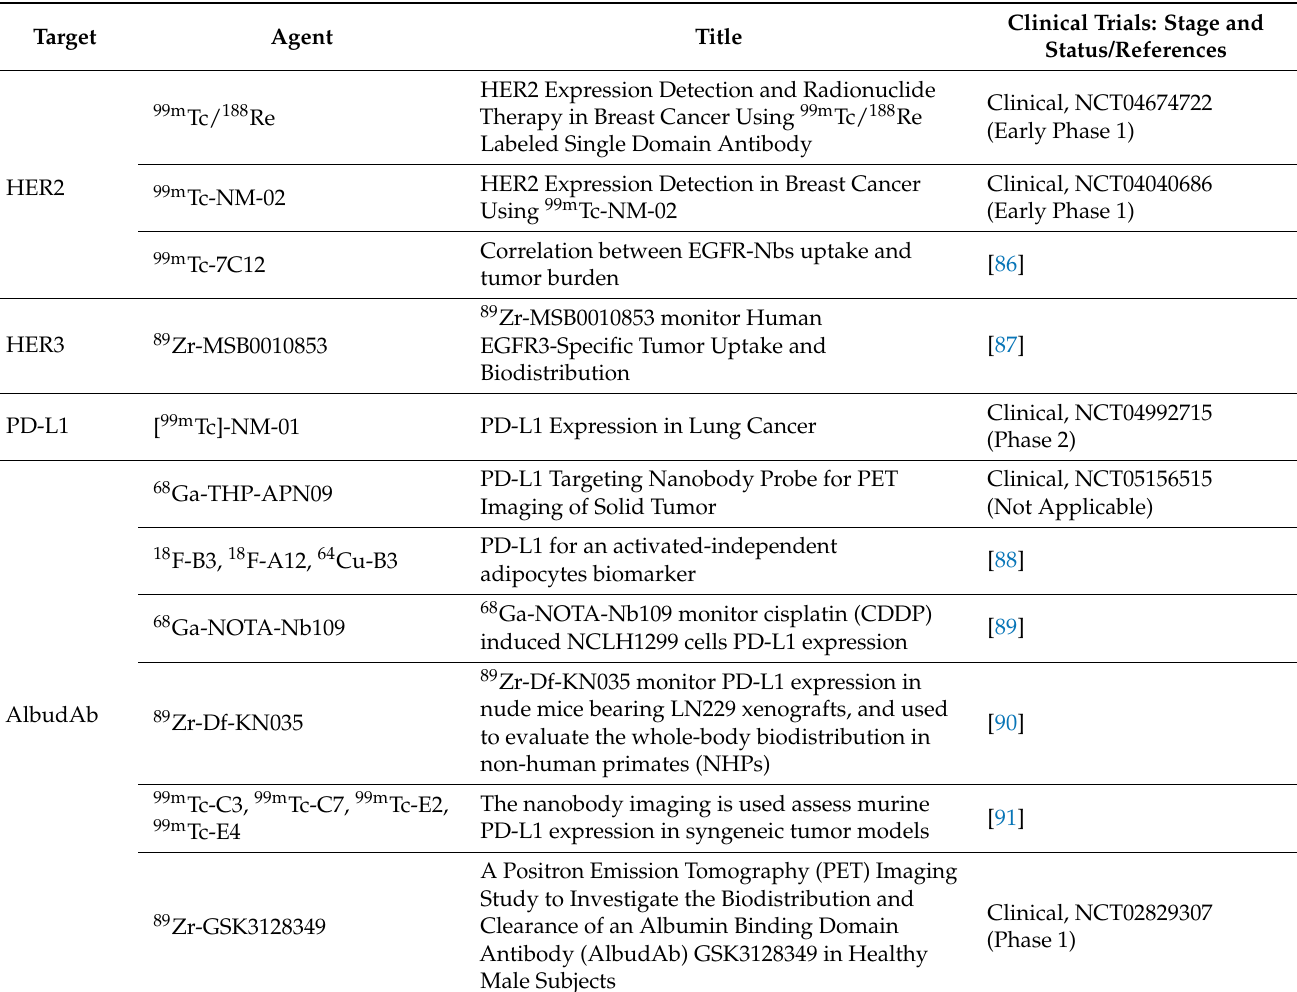
Table 1. Nanobody development for preclinical molecular diagnostics (Data sources for clinical trials: https://clinicaltrials.gov/, accessed on 9 August